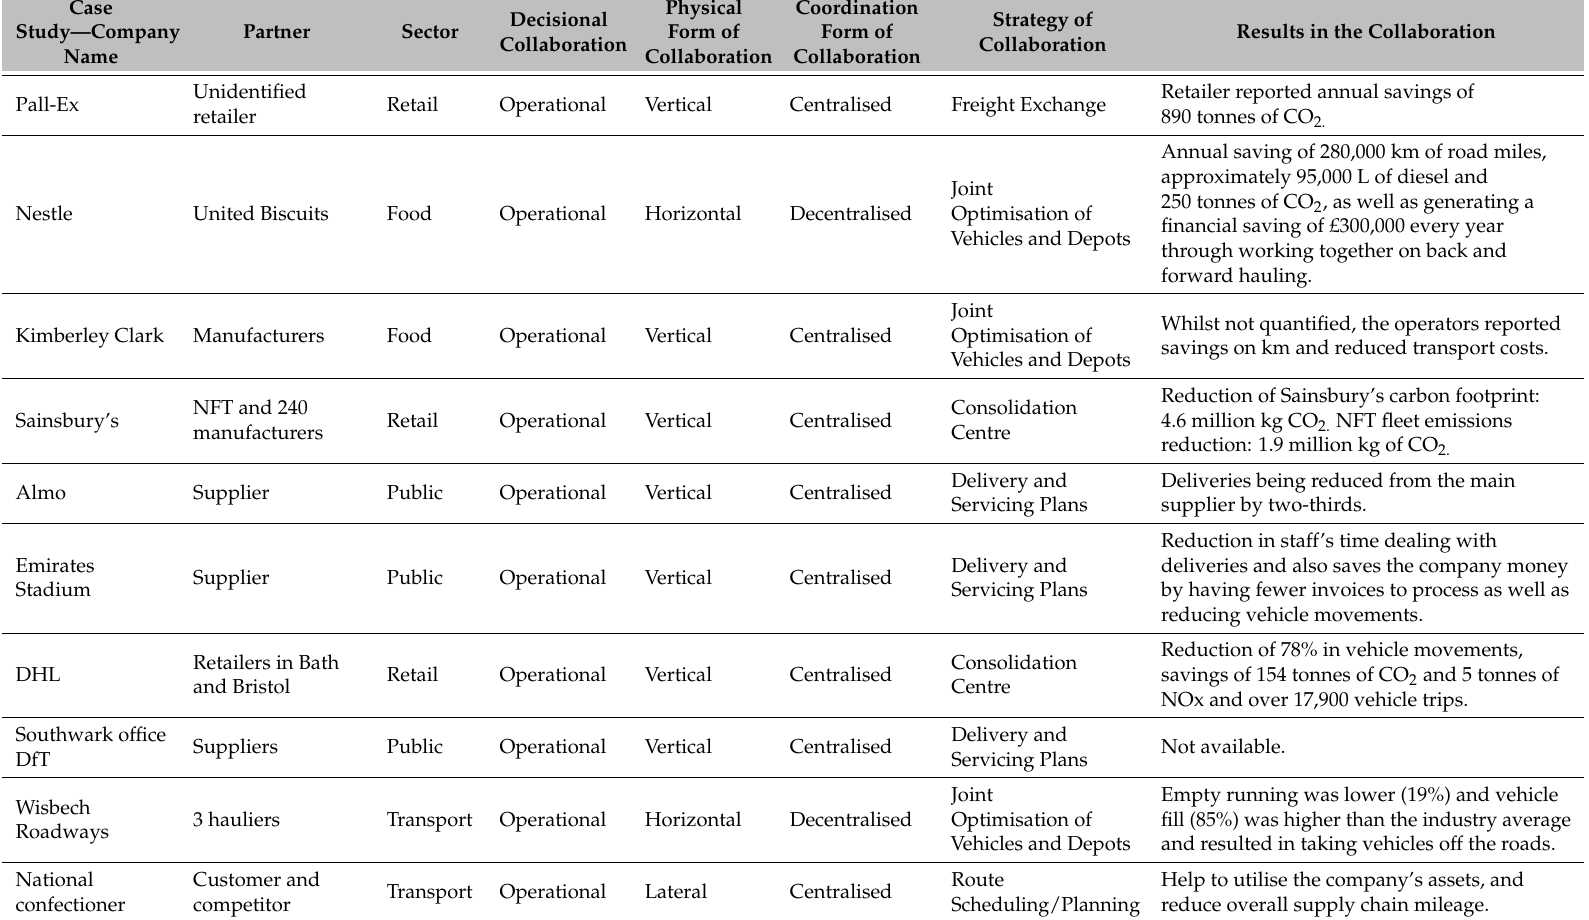
Table 1. Cases studies of freight industry collaboration in the United Kingdom. Source: Aggregated data from [1] with concepts from [14–17]. Case